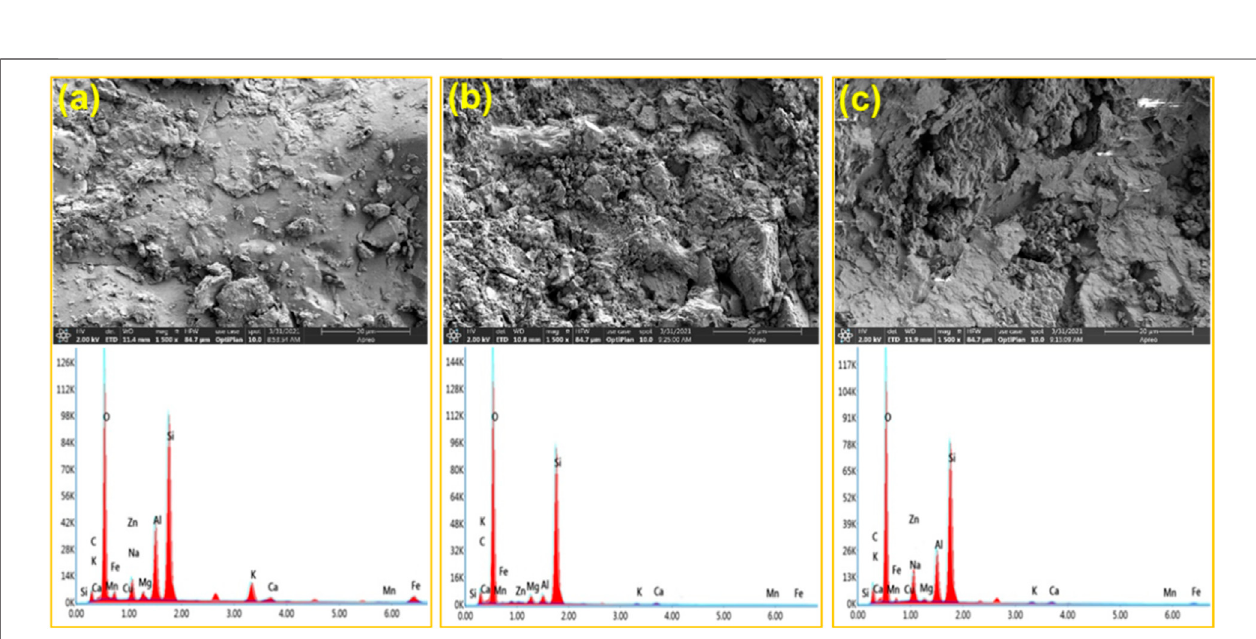
FIGURE 11 | SEM-EDS analysis of acid-core etching: (A) untreated core; (B) core etched by dibasic acid; (C) core etched by 0.3% VES-c dibasic acid. The top is the SEM fi gure and the corresponding bottom is the EDS fi gure.